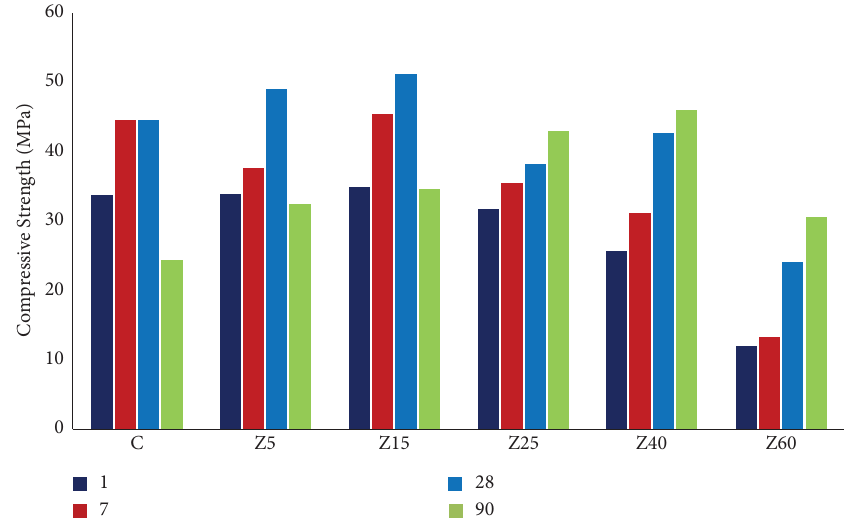
Figure 3: Compressive strength of the zeolite mixtures at the age of 1 to 90 days.